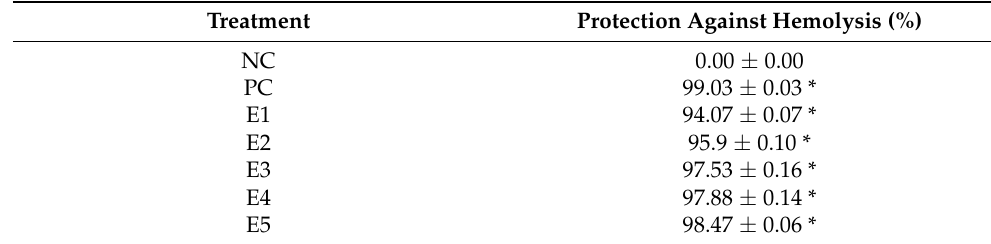
Table 1. Average ± SD of saponins equivalent to the standard g/100 g of dry extract. Saponins